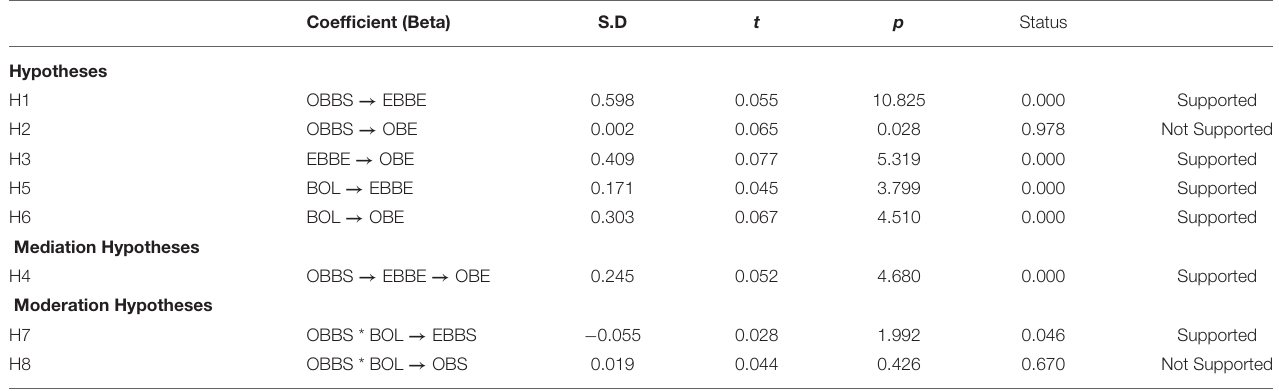
TABLE 5 | Hypotheses